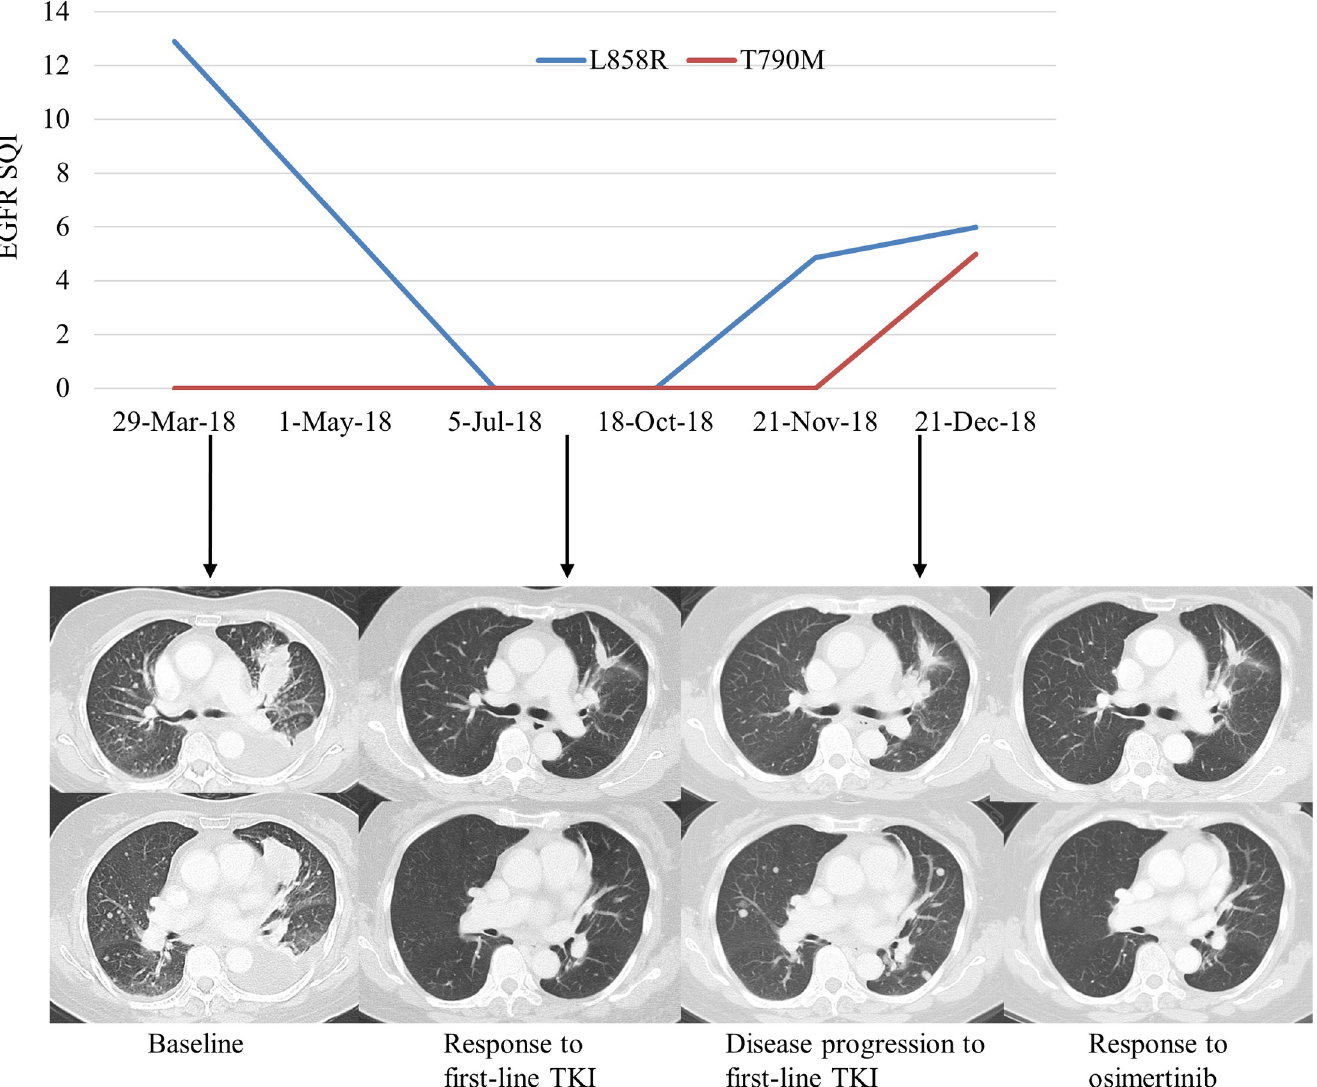
Fig 4. Case study of a patient with L858R and T790M mutations who progressed on first-line TKI therapy. Analysis of EGFR SQI for each mutation over time with corresponding serial chest imaging.